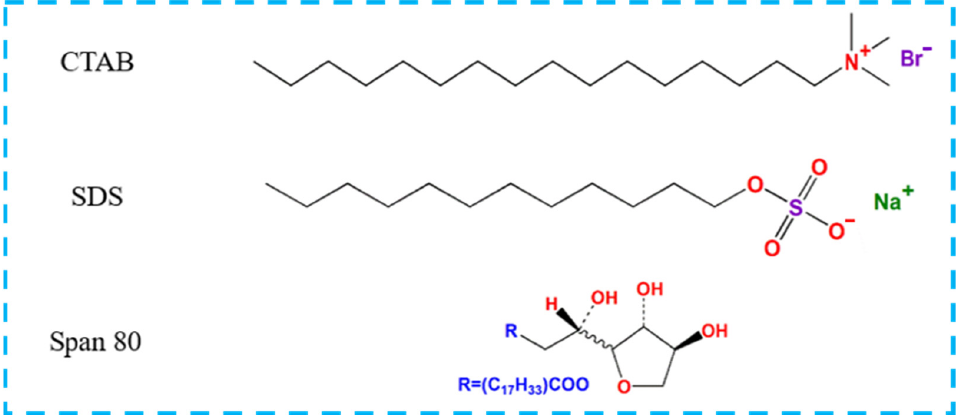
Figure 1. Molecular structure of surfactants.